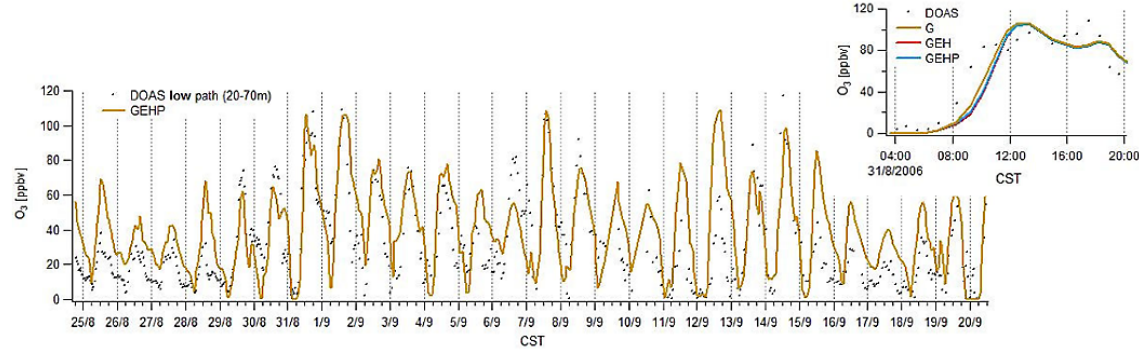
Fig. 7. Time series comparison of O 3 measured from the Moody Tower by DOAS low light-path with simulated mixing ratios for 25 August– 20 September 2006. The insert shows a blow-up for 31 August 2006, displaying all three model simulations vs. the observed O 3 data on that